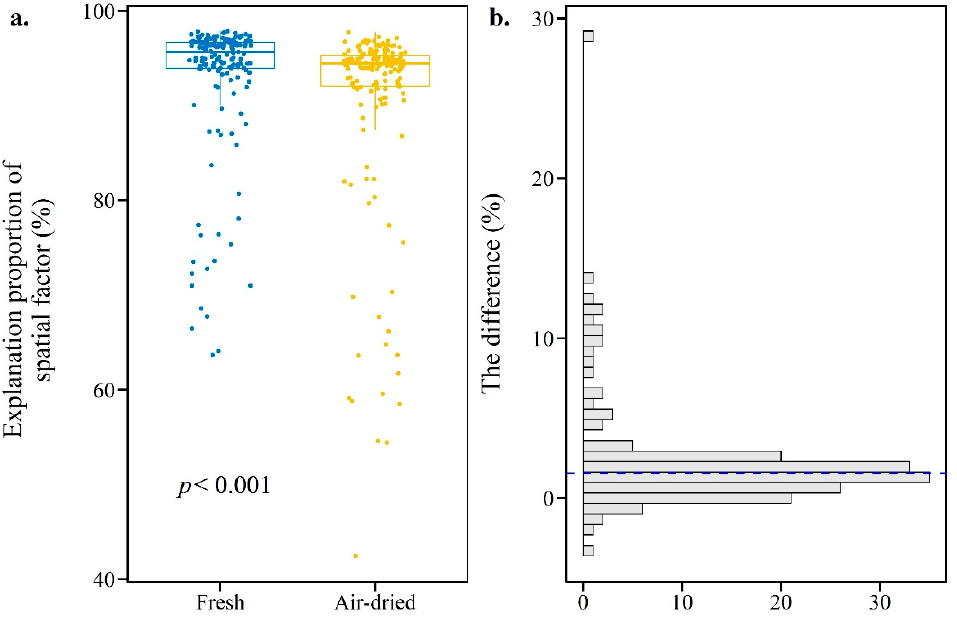
Figure 3. The proportion of explanation for the spatial factor which drives the microbial community structure in fresh soils (blue) and air-dried soils (yellow) ( a ). The distribution of the difference in the proportion of explanation for the spatial factor between fresh soils and air-dried soils. The x-axis represents frequency, and the blue dash line represents median value ( b ).